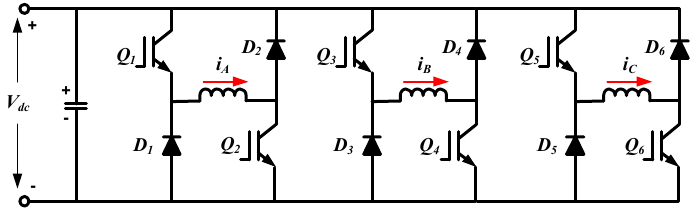
Figure 10. Topology of the asymmetric converter for the two motors.